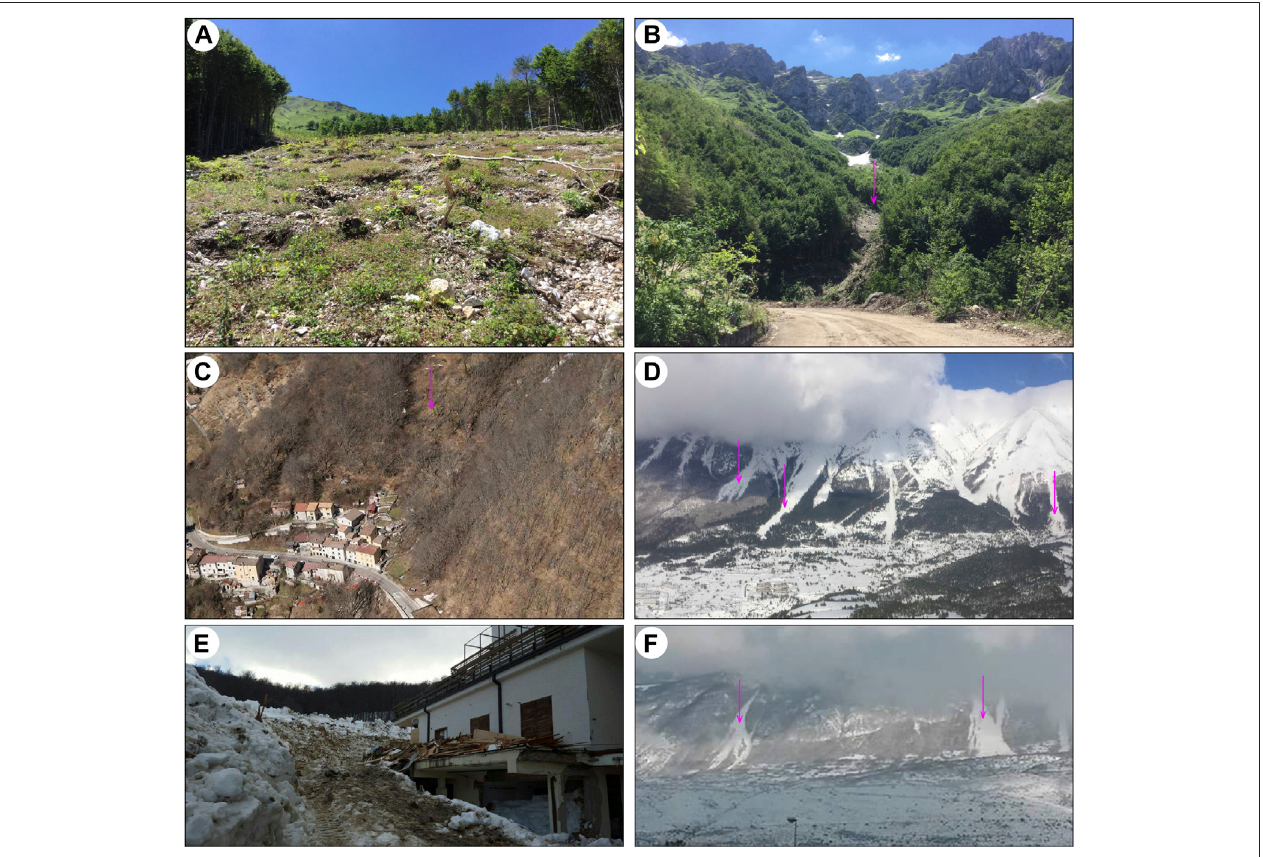
FIGURE7| ExamplesoftheavalanchesonJanuary 18 – 19, 2017(pink arrows) or postsnow-meltevidence (location in Figure 6 ): (A) NE slope ofMonteSiella, (B) NEslopeofSelladiTramoggia, (C) Ortolano(TE)(sourceYoureporter,2017), (D) Assergi(AQ)(sourceIlCapoluogo,2017), (E) PratidiTivo(TE)(sourceIlMartino,2017), and (F) Villa Santa Lucia (AQ) (source Abruzzo Live,